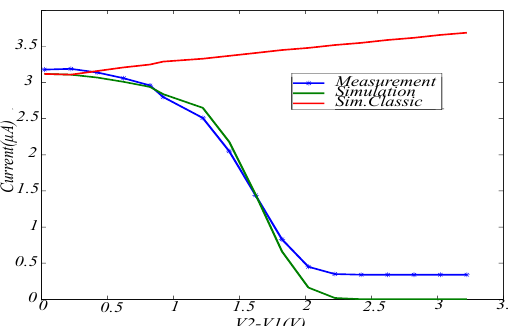
Figure 18. Measurement result of the total power consumption when V 1 decreases from Vdd /2 to zero and V 2 increases from Vdd /2 to Vdd